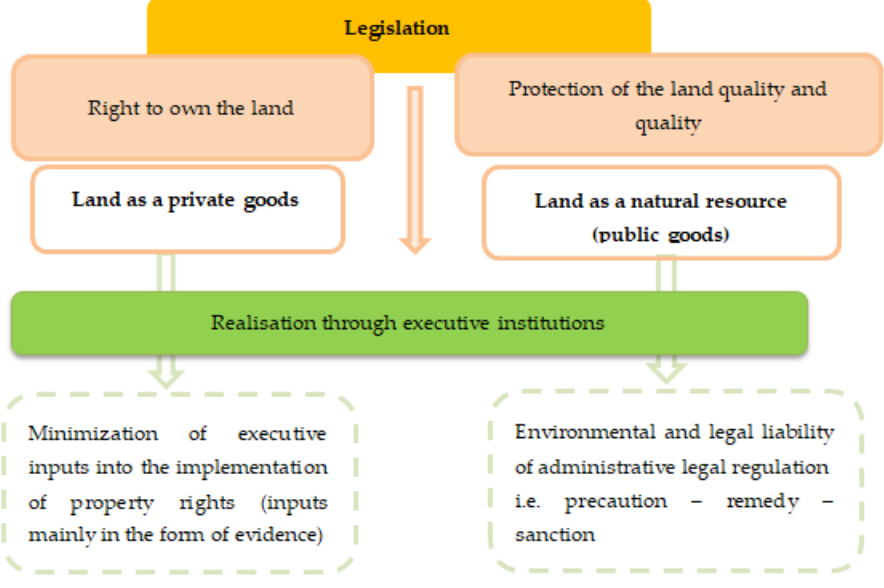
Figure 7. Legal regulation of agricultural land in Slovakia. Source: own representation, 2021.